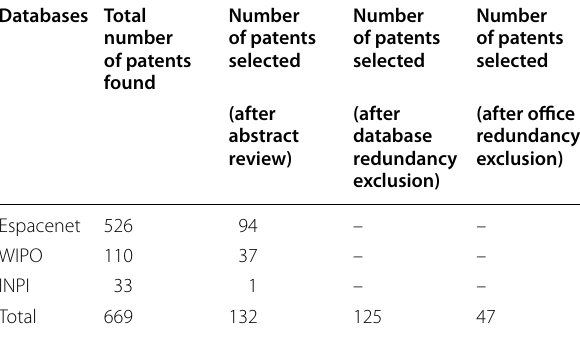
Table 1 Total number of patents related to microalgae in agriculture found in each database and the number of patents selected after each